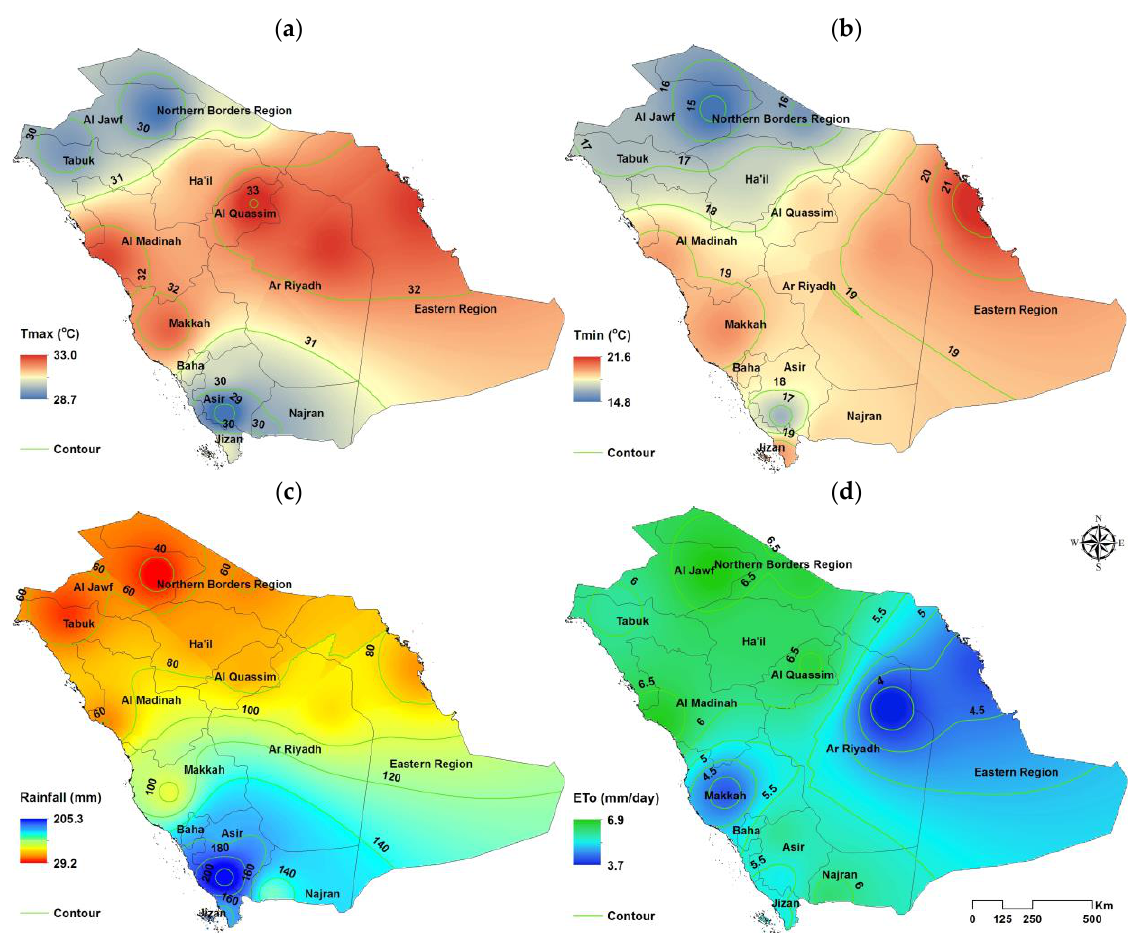
Figure 2. ( a ) Maximum and ( b ) minimum temperature (°C), ( c ) rainfall (mm), and ( d ) reference evapotranspiration (ETo) (mm) for 1991 – 2020. evapotranspiration (ETo) (mm) for